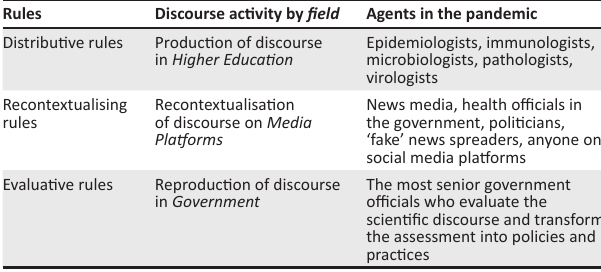
TABLE 1: Division of knowledge labour in